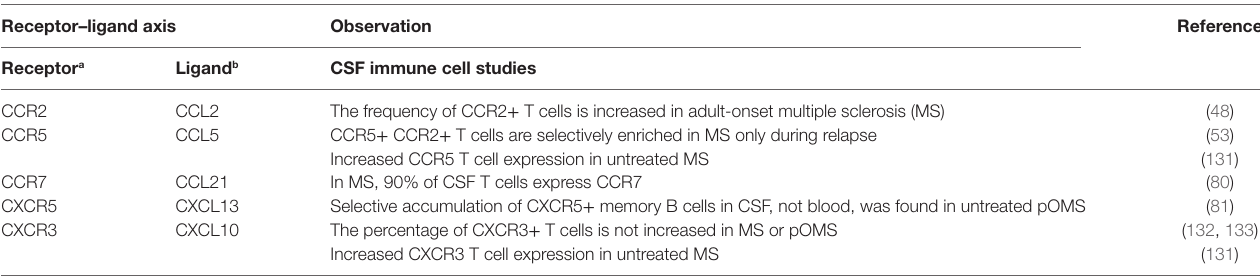
TABle 6 | Disease effect on chemokine receptor (CKR) expression in selected neuroinflammatory disorders. Receptor–ligand